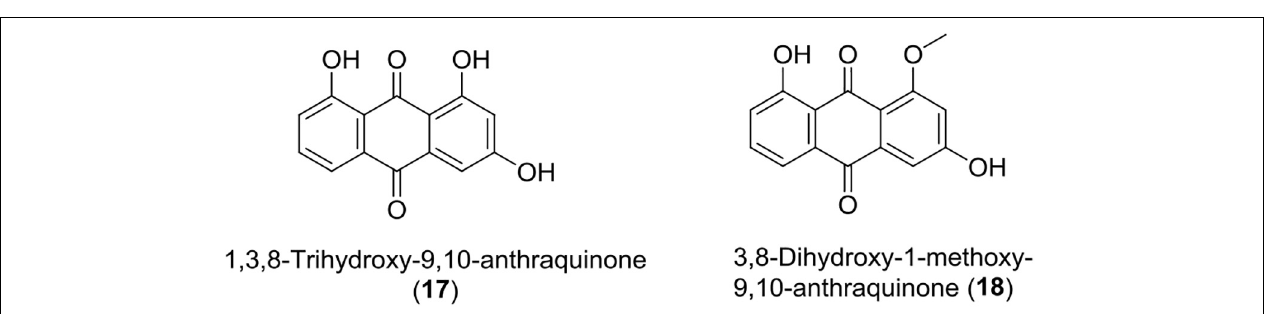
FIGURE 6 | Chemical structure of anti-inflammatory compounds (17–18)